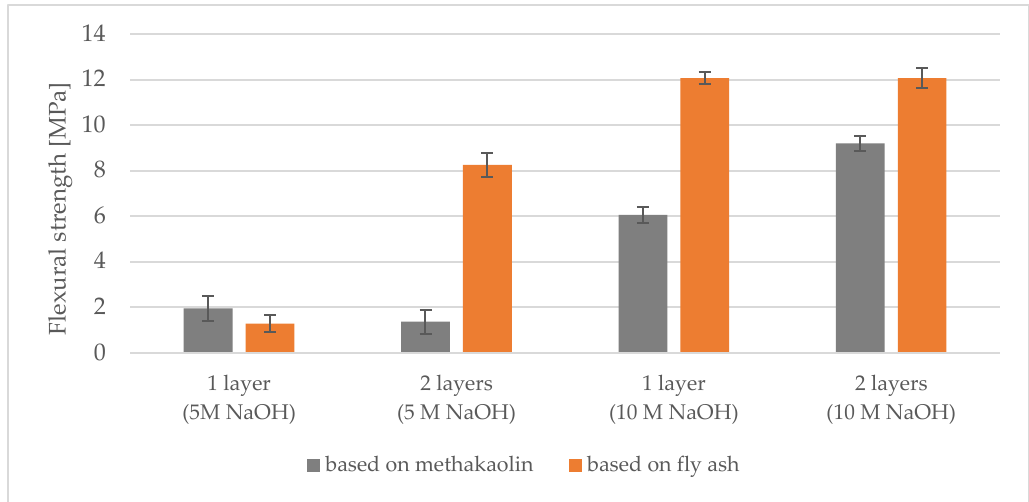
Figure 17. Flexural strength for metakaolin and fly ash-based geopolymers reinforced with a basalt grid.